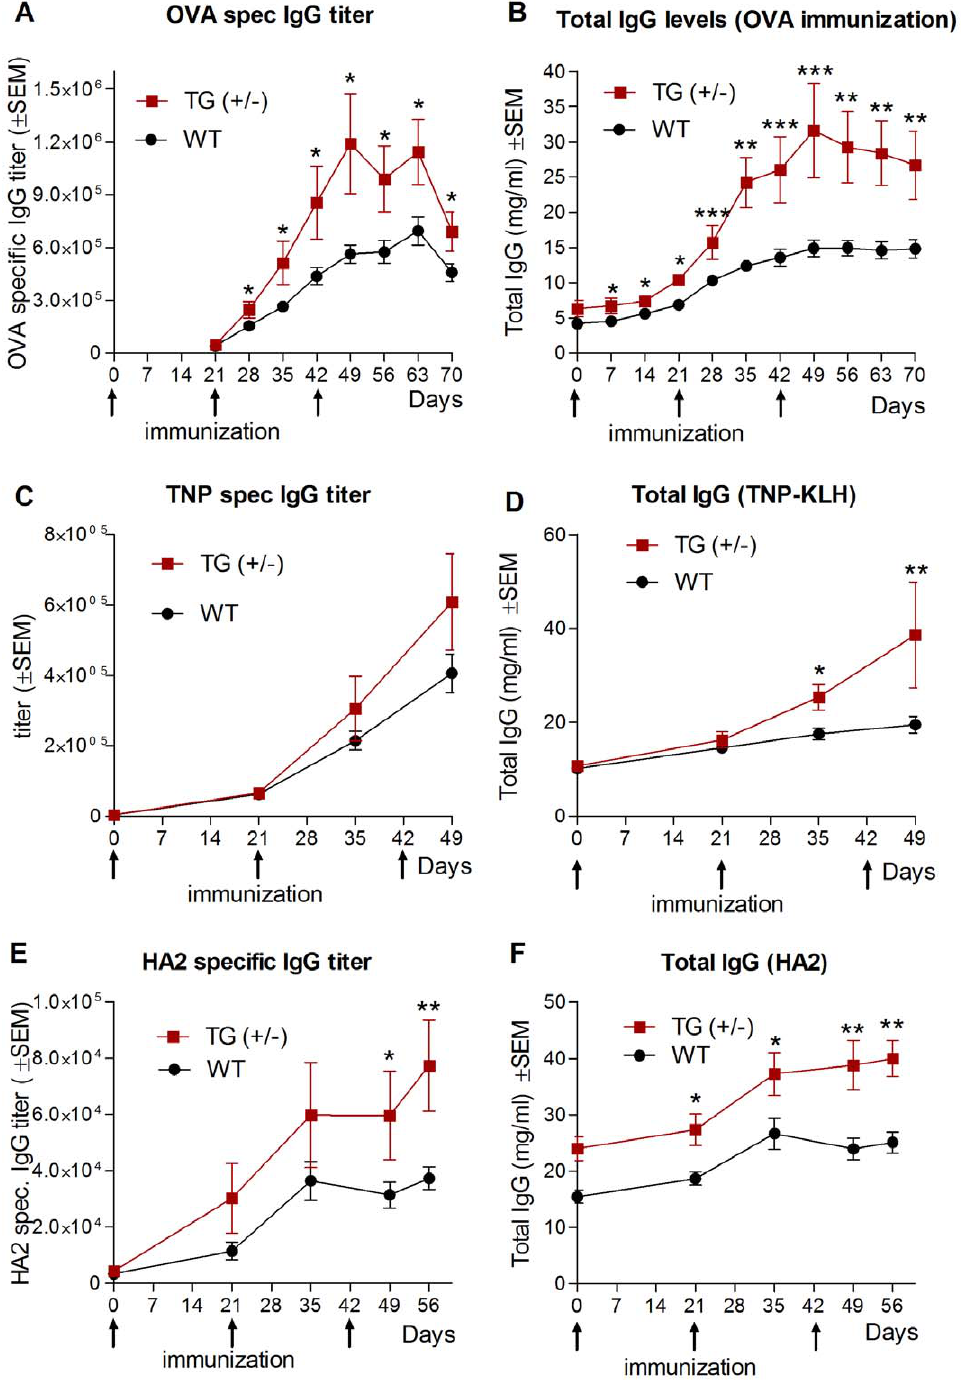
Figure 9. Augmented humoral immune response in transgenic rabbits. A–B . Tg + / 2 and wt rabbits (4 and 8 animals, respectively) were immunized with OVA. After the booster immunization the OVA-specific IgG titers were nearly double in Tg rabbits as compared with the wt animals. We found that the total IgG levels rose steadily after immunization and reached peak levels on day 49 in Tg and wt animals. C–D . Tg + / 2 and wt rabbits (5 and 5, respectively) were immunized with TNP-BSA. The mean TNP-specific IgG level was higher in Tg rabbits as compared to their wt controls at the peak of the immune response, on day 49, one week after the second booster immunization with an almost doubled level of total IgG as compared to their wt controls. E–F . The same rabbits which had been immunized with TNP-BSA, were immunized with a conserved influenza hemagglutinin epitope (HA2) conjugated to KLH. The mean of the HA2-specific IgG levels was double at the peak of the immune response, on day 56, two weeks after the second booster immunization, with an almost doubled level of total IgG as compared to their wt controls. Values shown are the means 6 SEM. (*, P , 0.05; **, P , 0.01; ***, P , 0.001.).